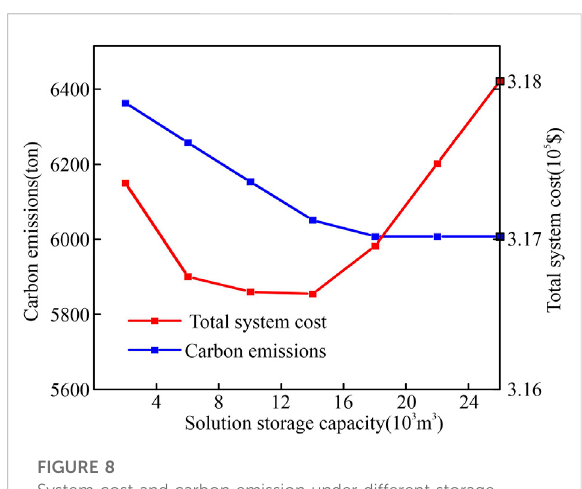
FIGURE 7 System carbon emissions under different scenarios.